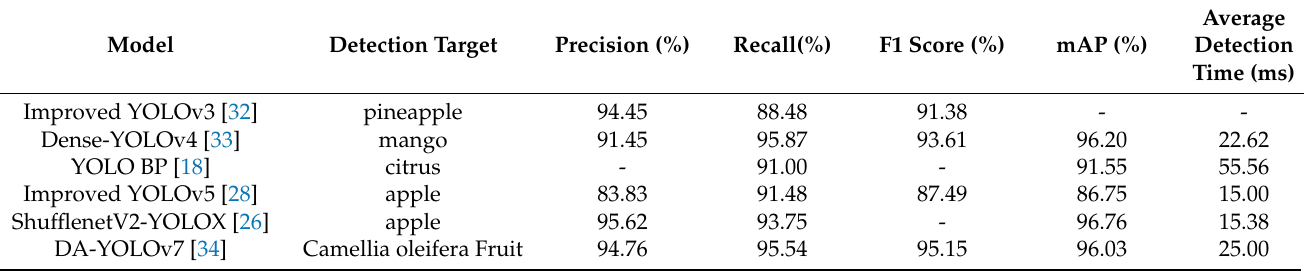
Table 1. Performance of related work.